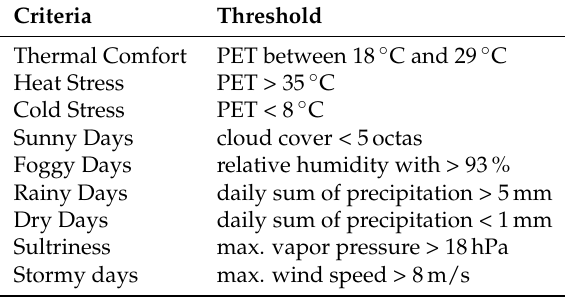
Table 2. Threshold criteria (adapted from Reference [21]) for the Climate-Tourism/Transfer-Information -Scheme